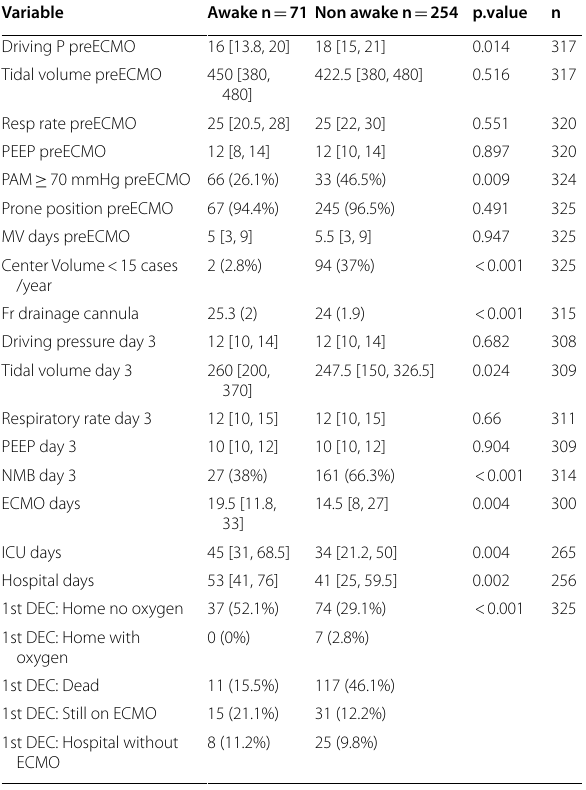
failure. Table 1 AUROC for ROX index at measured time points for HFNO suc- cess and